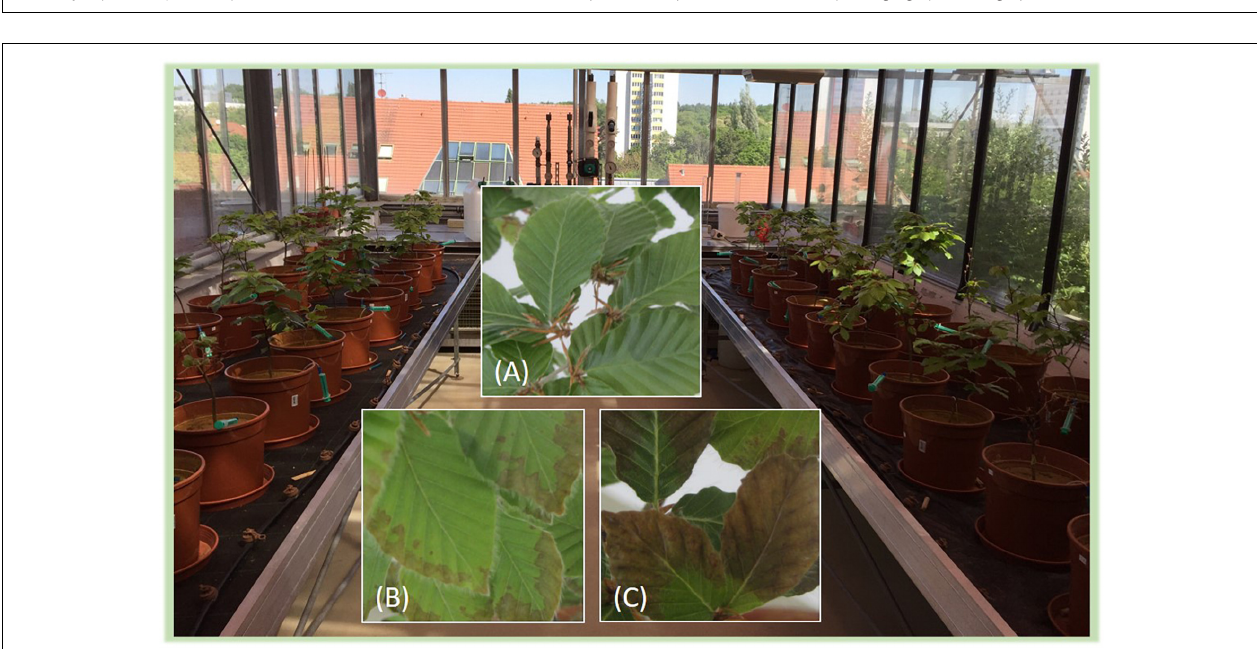
FIGURE 1 | Sorption isotherms of (A) phytate-P and (B) orthophosphate-P to the Lüss Bw horizon, both at pH 4.5 in 1 µ M KClO 4 solution as a background electrolyte (ca. 100 µ S cm - 1 ); the amount of P fertilized in the mesocosm experiment equals the second dot (2.8 mg kg - 1 ) in both graphics.